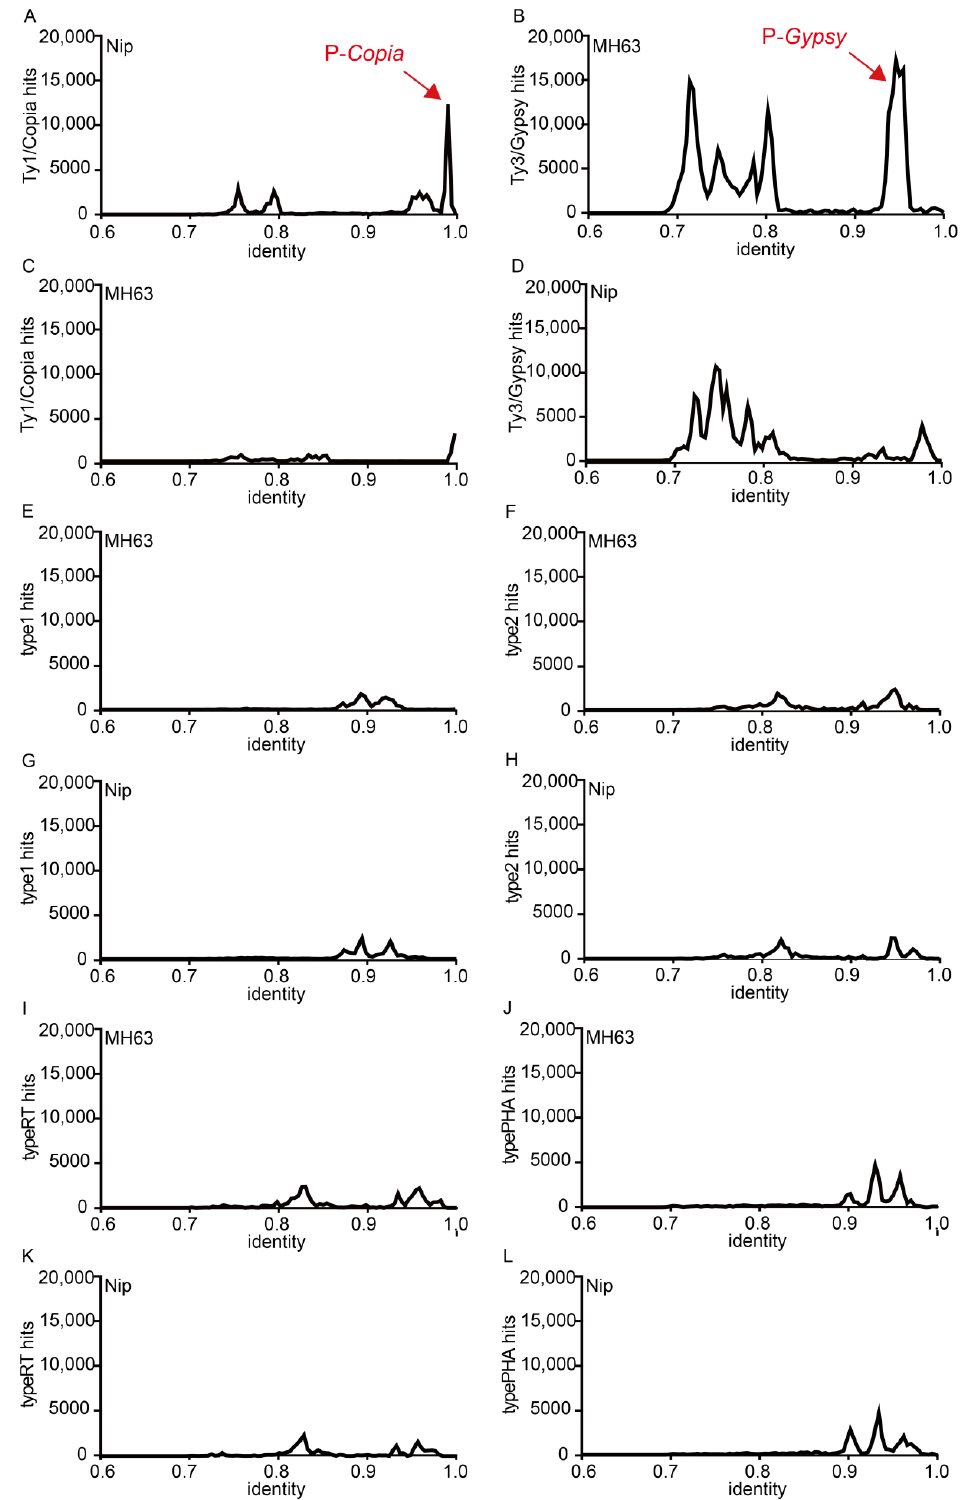
2 Figure 3. Scanning of the Nip and MH63 whole genomes with the TE ORF reference sequences. ( A ) Nip genome scanning after normalization with ref-N-Ty1 / Copia . ( B ) MH63 genome scanning after normalization with ref-M-Ty3 / Gypsy . ( C – L ) in the same format as ( A ), for Ty1 / Copia , Ty3 / Gypsy , type1 , type2 , typeRT and typePHA, respectively. Individual TE peaks P- Copia ( p value = 0.0001) and P- Gypsy ( p value = 0.008) were observed in the Nip and MH63 genomes